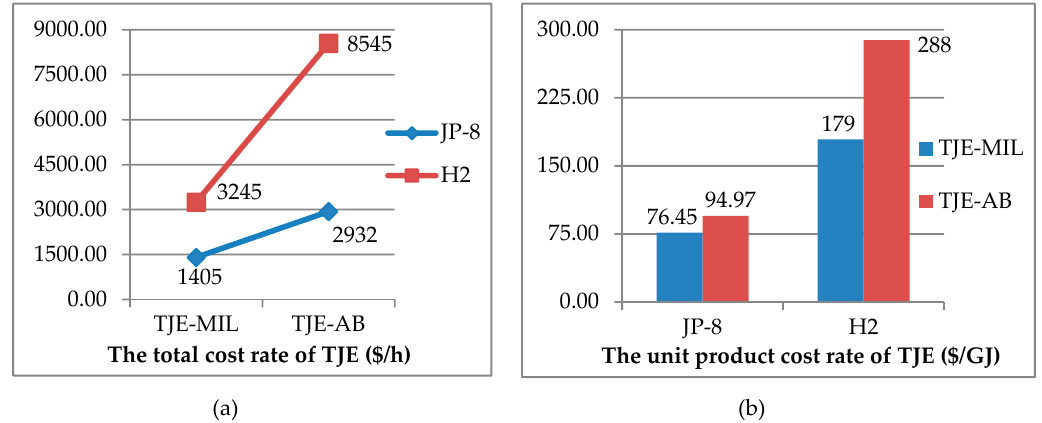
Figure 9. (a) The TJE’s total cost rate; (b) The TJE’s unit product cost rate. Figure 9. ( a ) The TJE’s total cost rate; ( b ) The TJE’s unit product cost rate.